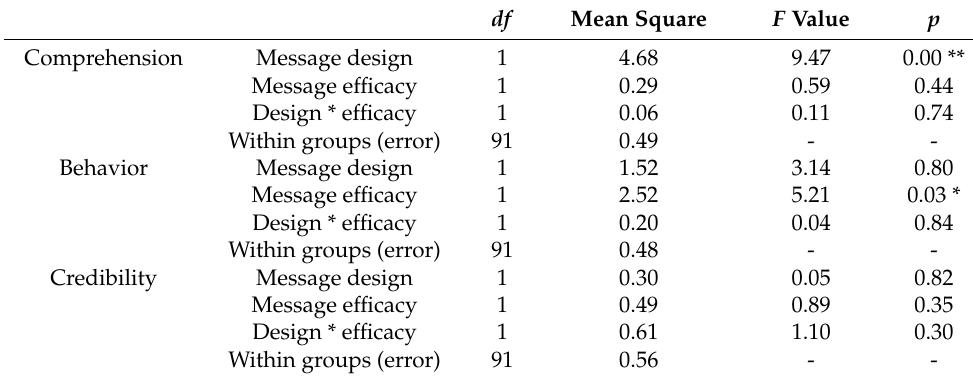
Table 2. Table of two-way ANOVA